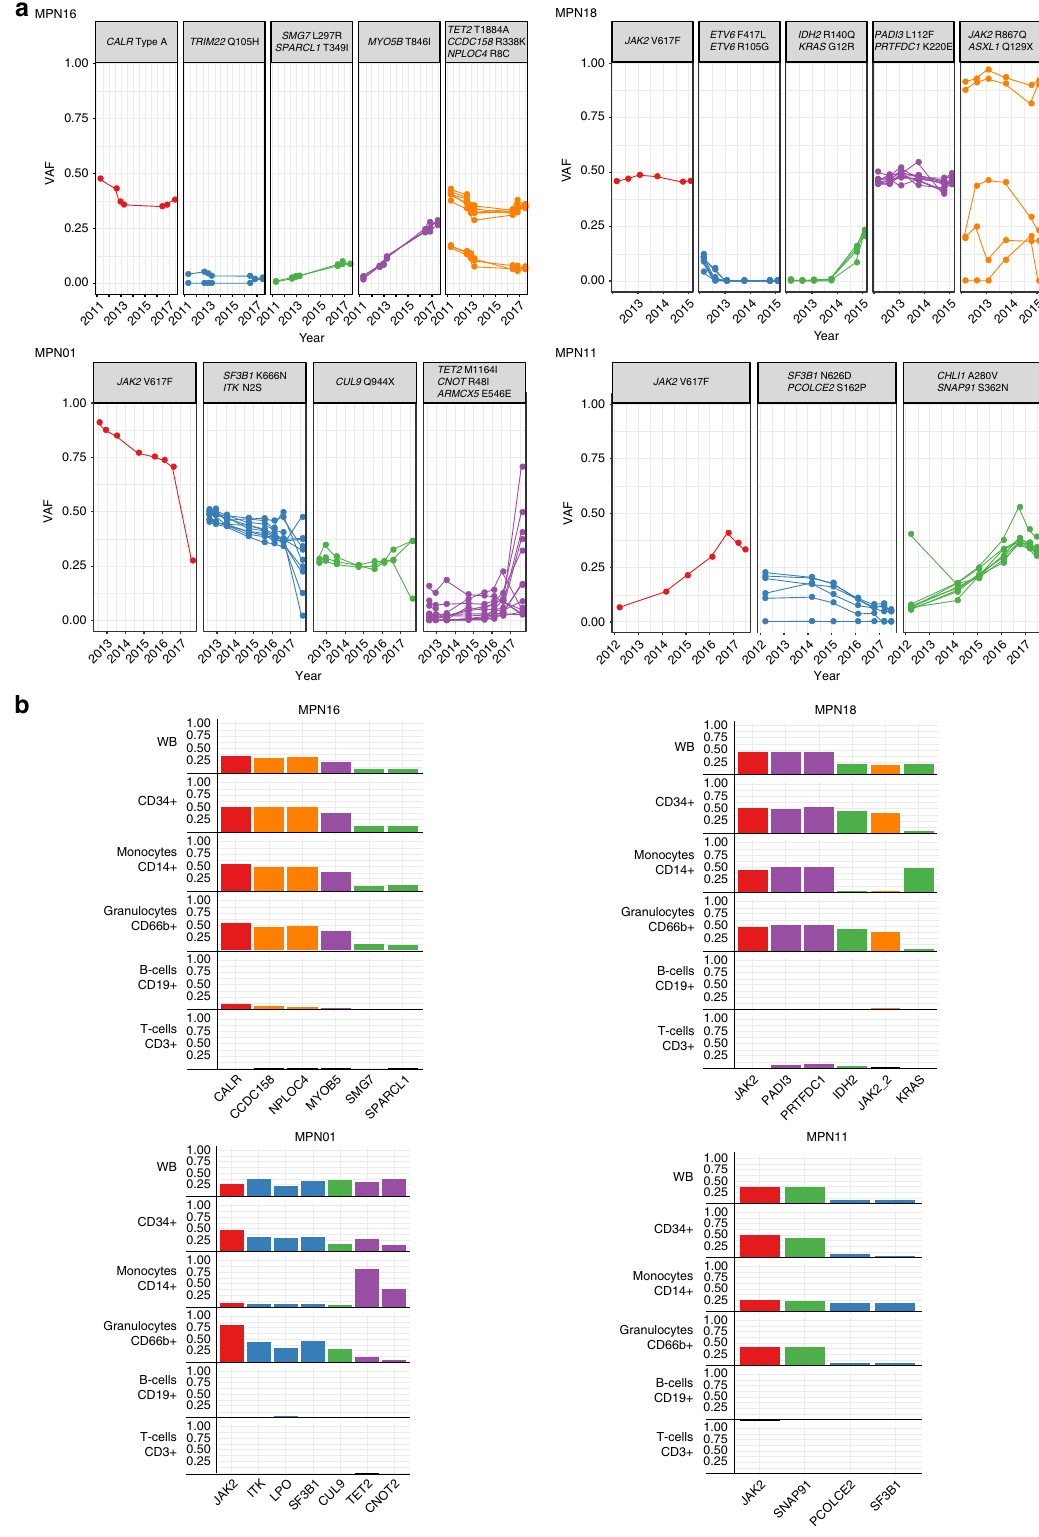
Fig. 3 VAF-based clonal evolution analysis and allele burden quanti fi cation in fl ow-sorted cell fractions. a Mutations clustered by VAF generated from ultra-deep sequencing at various follow-up time points. Disease-de fi ning mutations in JAK2/ CALR are depicted independently to emphasize their speci fi c role in disease pathogenesis. From each cluster representative mutated genes were selected. b Representative mutation distribution in different blood lineages. Patients with differential segregation of mutations are displayed. Bar color correspond to respective clones shown in a . Source data are provided as a Source Data fi